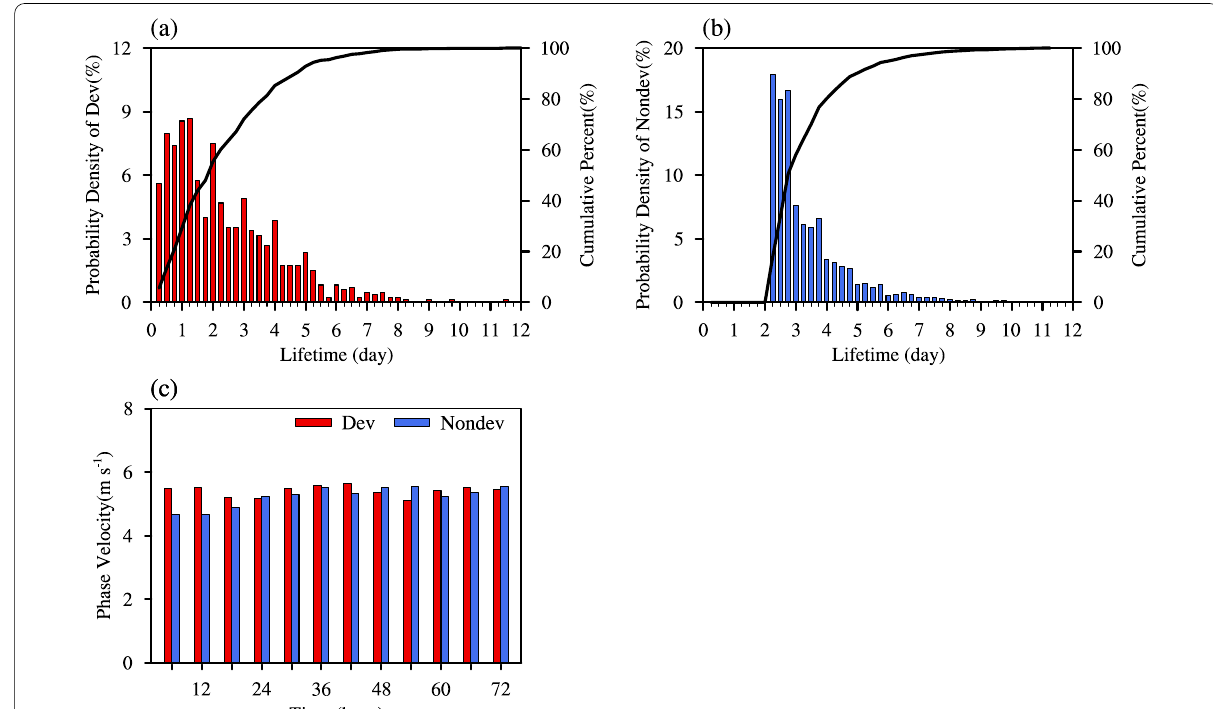
Fig. 3 The lifetime distributions of a developing and b nondeveloping disturbances over the WNP from June to November of 1965 to 2020. The X-axis represents the duration time. The left Y-axis indicates the corresponding probability density of the disturbances. The right Y-axis indicates the cumulative percent. c The propagation speed of the developing (nondeveloping) disturbances within 72 h before the time of TC genesis (disturbance dissipation) (unit: m s − 1